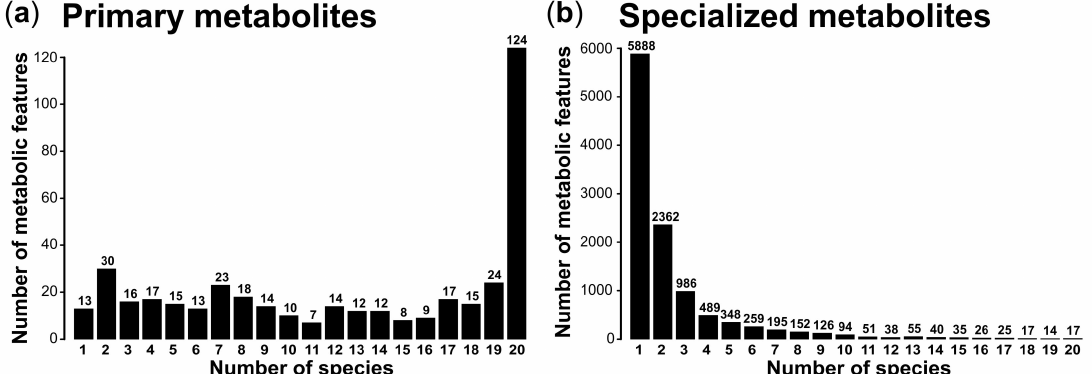
Figure 1. Frequency of occurrence of metabolic features of the ( a ) primary and ( b ) specialized metabolism detected in leaves of 20 plant